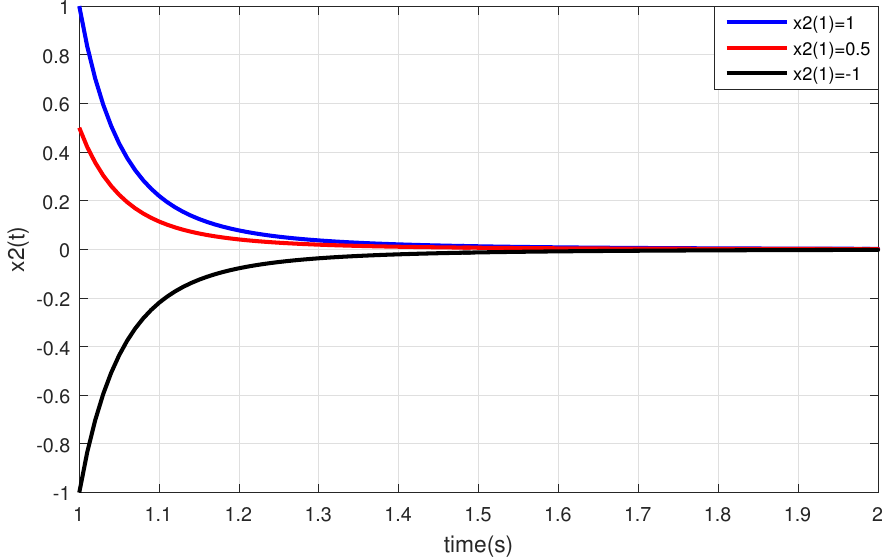
Figure 2. This figure shows that the solution x 2 ( t ) of the system of DDEs (11) with two multiple time-varying delays is uniformly asymptotically stable and the norm of this solution is integrable ( t ) = 1 | sin t | , h | sin t | , t ≥ 1 , and different initial for h 1 ( t ) = 1 2 2 4